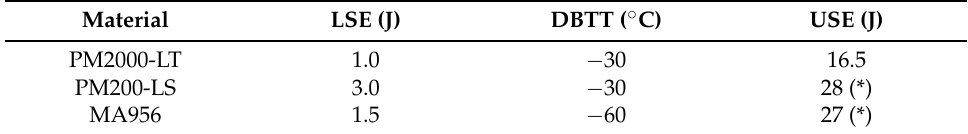
Table 3. Values of the parameters of the DBT